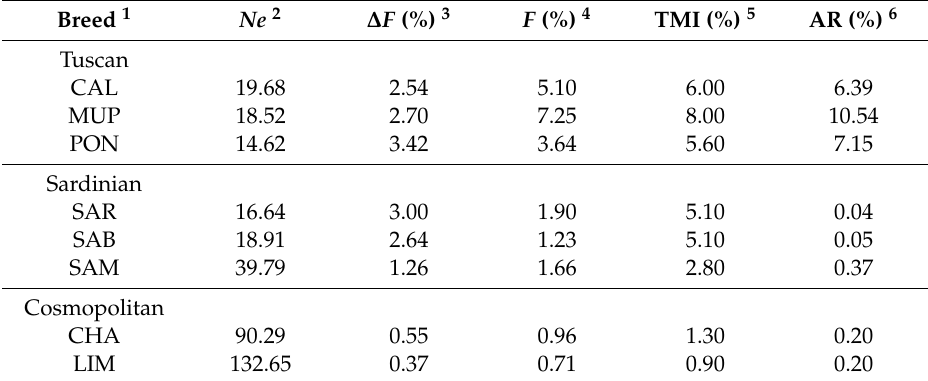
Table 4. Genetic variability parameters for each